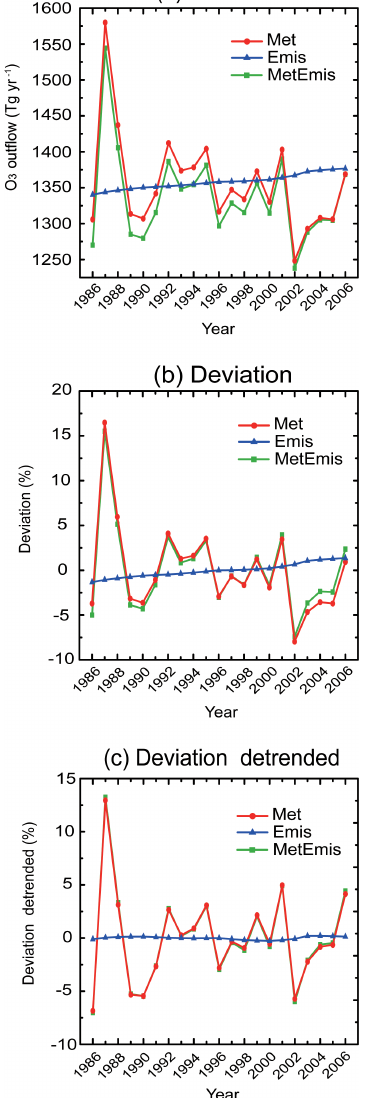
Figure 7. The evolution of the following: (a) the annual O 3 outflow fluxes (Tgyr − 1 ) across the meridional plane along 135 ◦ E from 20 to 55 ◦ N and from the surface to 100hPa from 1986–2006 in the Met, Emis, and MetEmis simulations; (b) the associated deviations from the mean (%); and (c) the deviations from the mean (%) of the detrended O 3 outflow fluxes. The deviation from the mean (DEV) is defined in Sect.